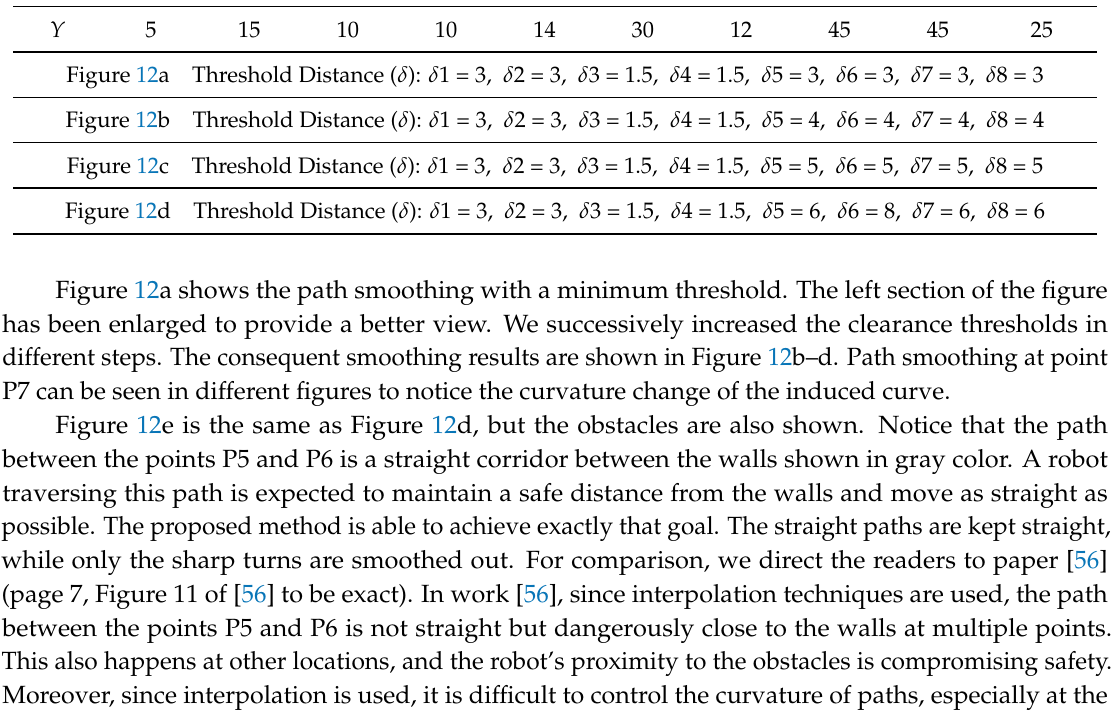
Figure 12a Threshold Distance ( δ ): δ 1 = 3, δ 2 = 3, δ 3 = 1.5, δ 4 = 1.5, δ 5 = 3, δ 6 = 3, δ 7 = 3, δ 8 = 3 Figure 12b Threshold Distance ( δ ): δ 1 = 3, δ 2 = 3, δ 3 = 1.5, δ 4 = 1.5, δ 5 = 4, δ 6 = 4, δ 7 = 4, δ 8 = 4 Figure 12c Threshold Distance ( δ ): δ 1 = 3, δ 2 = 3, δ 3 = 1.5, δ 4 = 1.5, δ 5 = 5, δ 6 = 5, δ 7 = 5, δ 8 = 5 Figure 12d Threshold Distance ( δ ): δ 1 = 3, δ 2 = 3, δ 3 = 1.5, δ 4 = 1.5, δ 5 = 6, δ 6 = 8, δ 7 = 6, δ 8 =